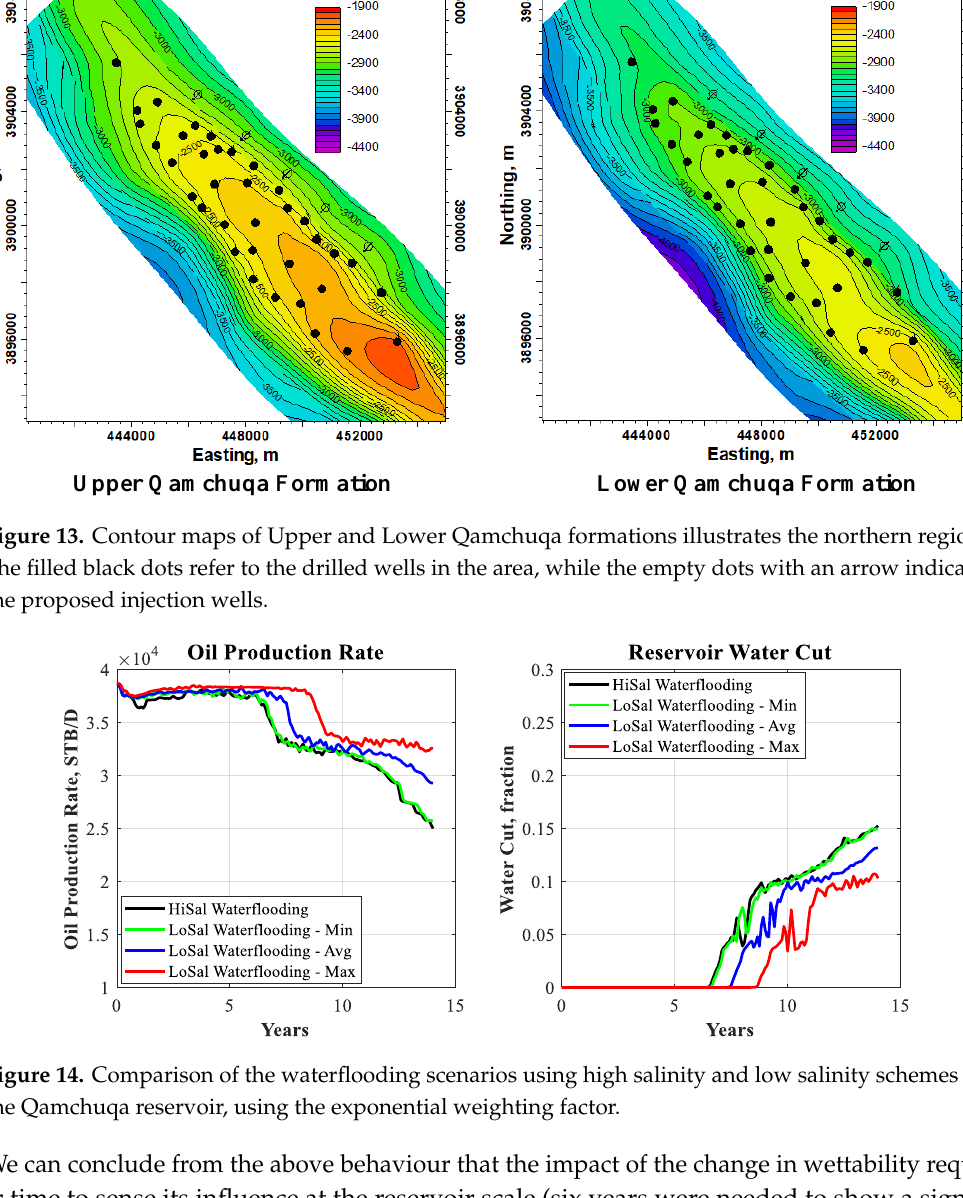
Figure 13. Contour maps of Upper and Lower Qamchuqa formations illustrates the northern region. The filled black dots refer to the drilled wells in the area, while the empty dots with an arrow indicate the proposed injection wells.